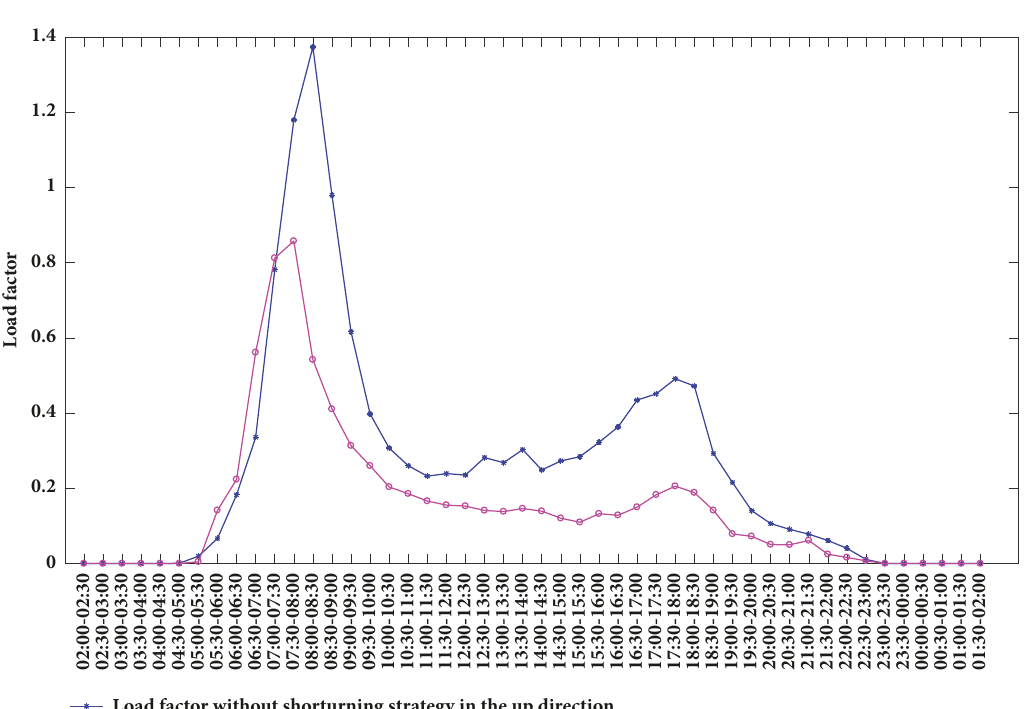
Figure 14: Load factor of a train service at east gate of Peking University